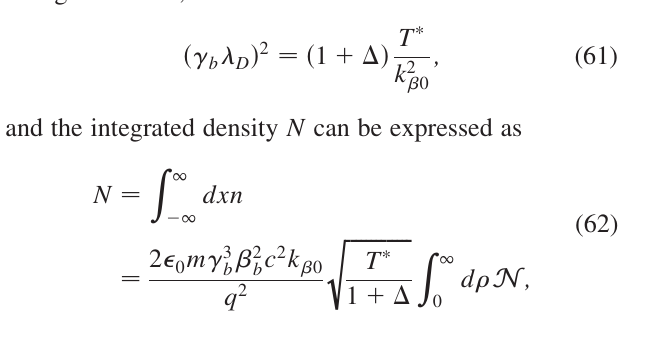
ffiffiffiffiffiffiffiffiffiffiffiffiffi